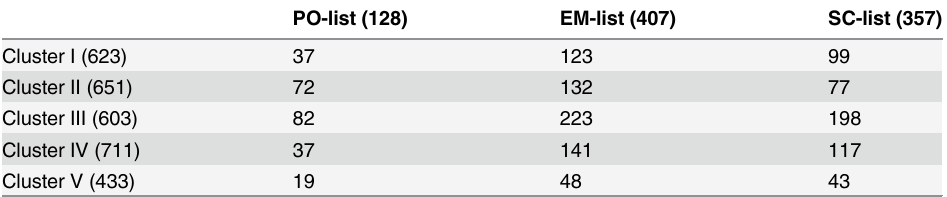
Table 3. Five clusters of human EMT-induction samples overlap differently with other